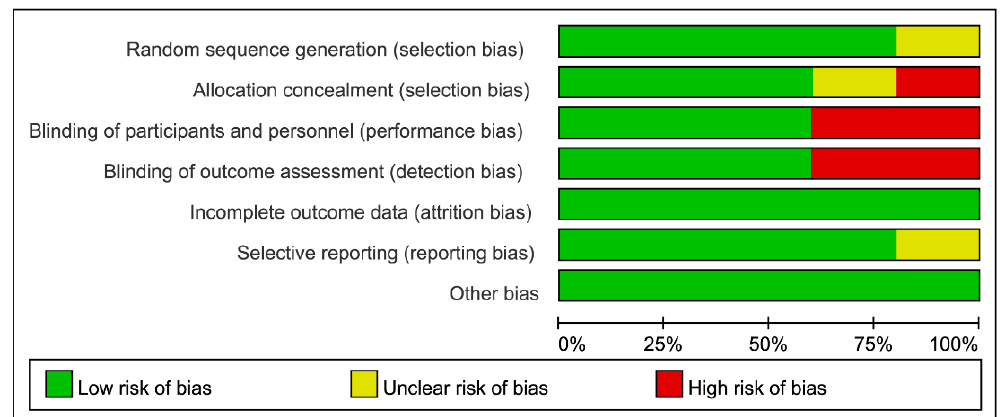
Figure 2. Risks of bias of individual studies.